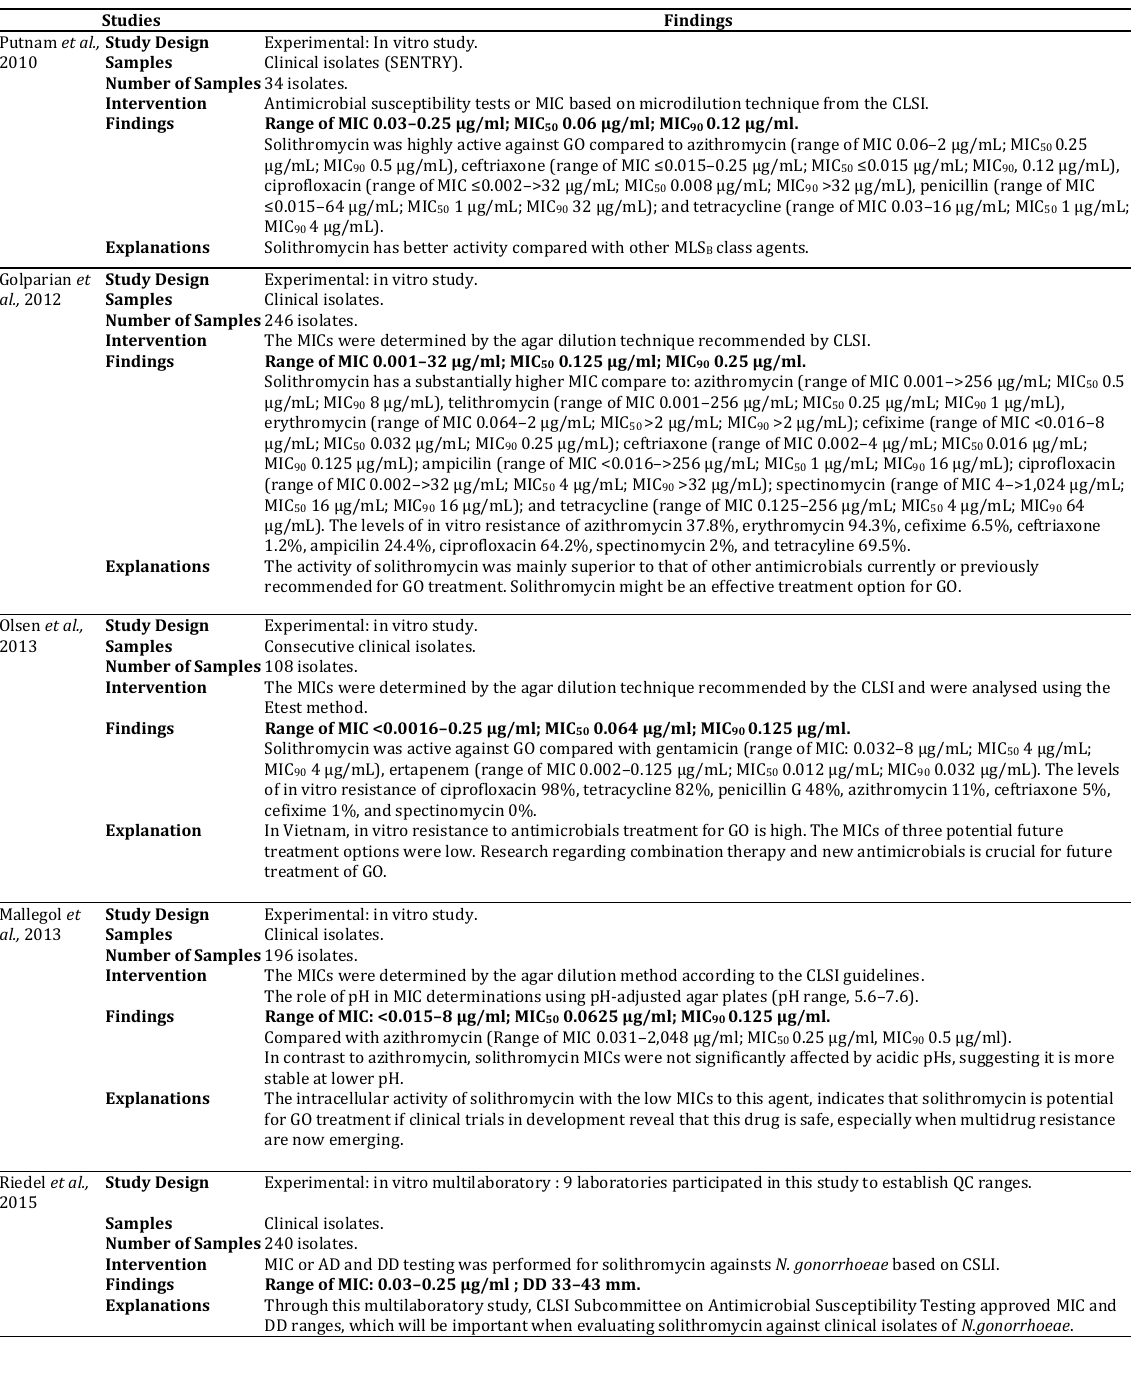
Table IIa. A Summary of multiple types of research about the antibacterial effect of solithromycin in combating N. gonorrhoeae